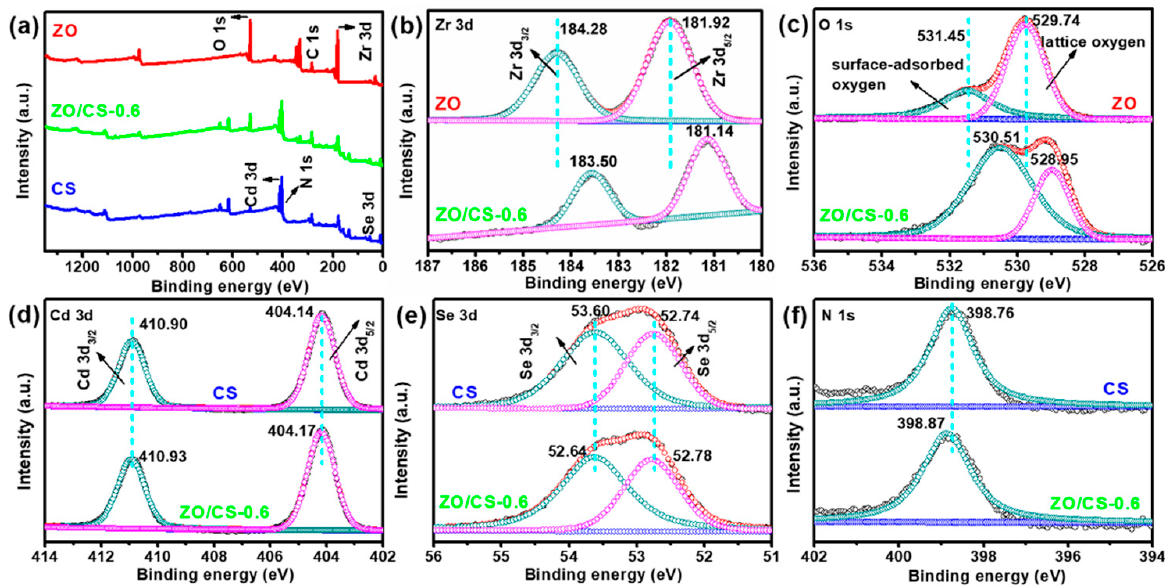
Figure 3. XPS spectra: ( a ) survey scan; ( b ) Zr 3d; ( c ) O 1s; ( d ) Cd 3d; ( e ) Se 3d and ( f ) N 1s.